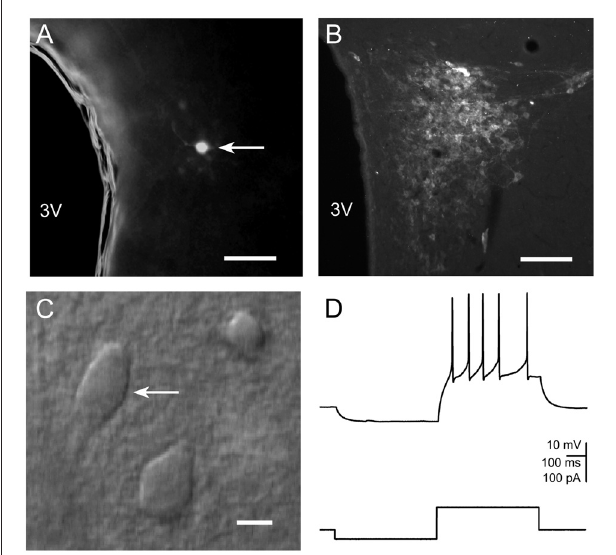
FIGURE 1 | (A) Photomicrograph illustrating a neurobiotin-filled presumable parvocellular neurosecretory cell (PNC) in the paraventricular nucleus (PVN). The third ventricle is labeled as 3V. Scale bar: 100 µ m. (B) Fluorescence image of a PVN slice immunostained for corticotropin-releasing hormone (CRH). Labels as in (A) . (C) IR-DIC image showing a presumable PVN neurosecretory neuron. Scale bar: 10 µ m. (D) A representative current clamp recording of a response of the cell shown in (C) to current